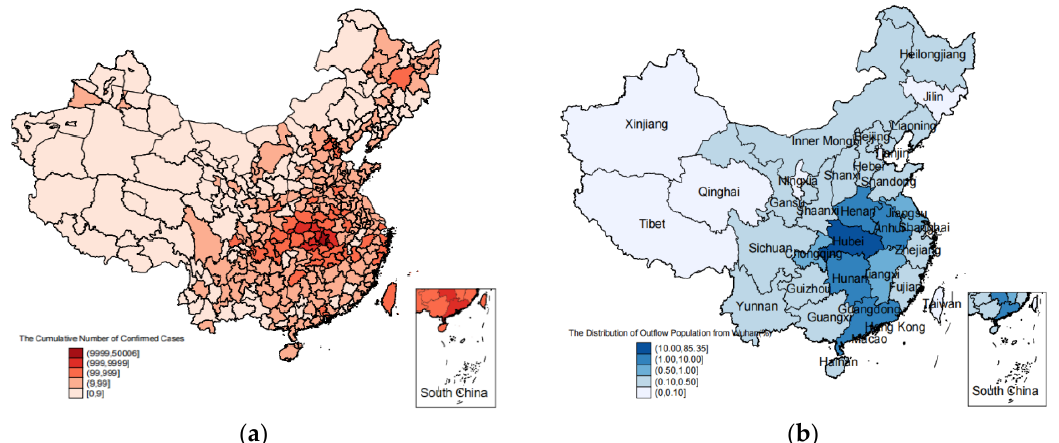
Figure 1. The distribution of the pandemic and the outflow population from Wuhan. ( a ) The distribution of the pandemic (as of 31 March 2020). ( b ) The distribution of the outflow population from